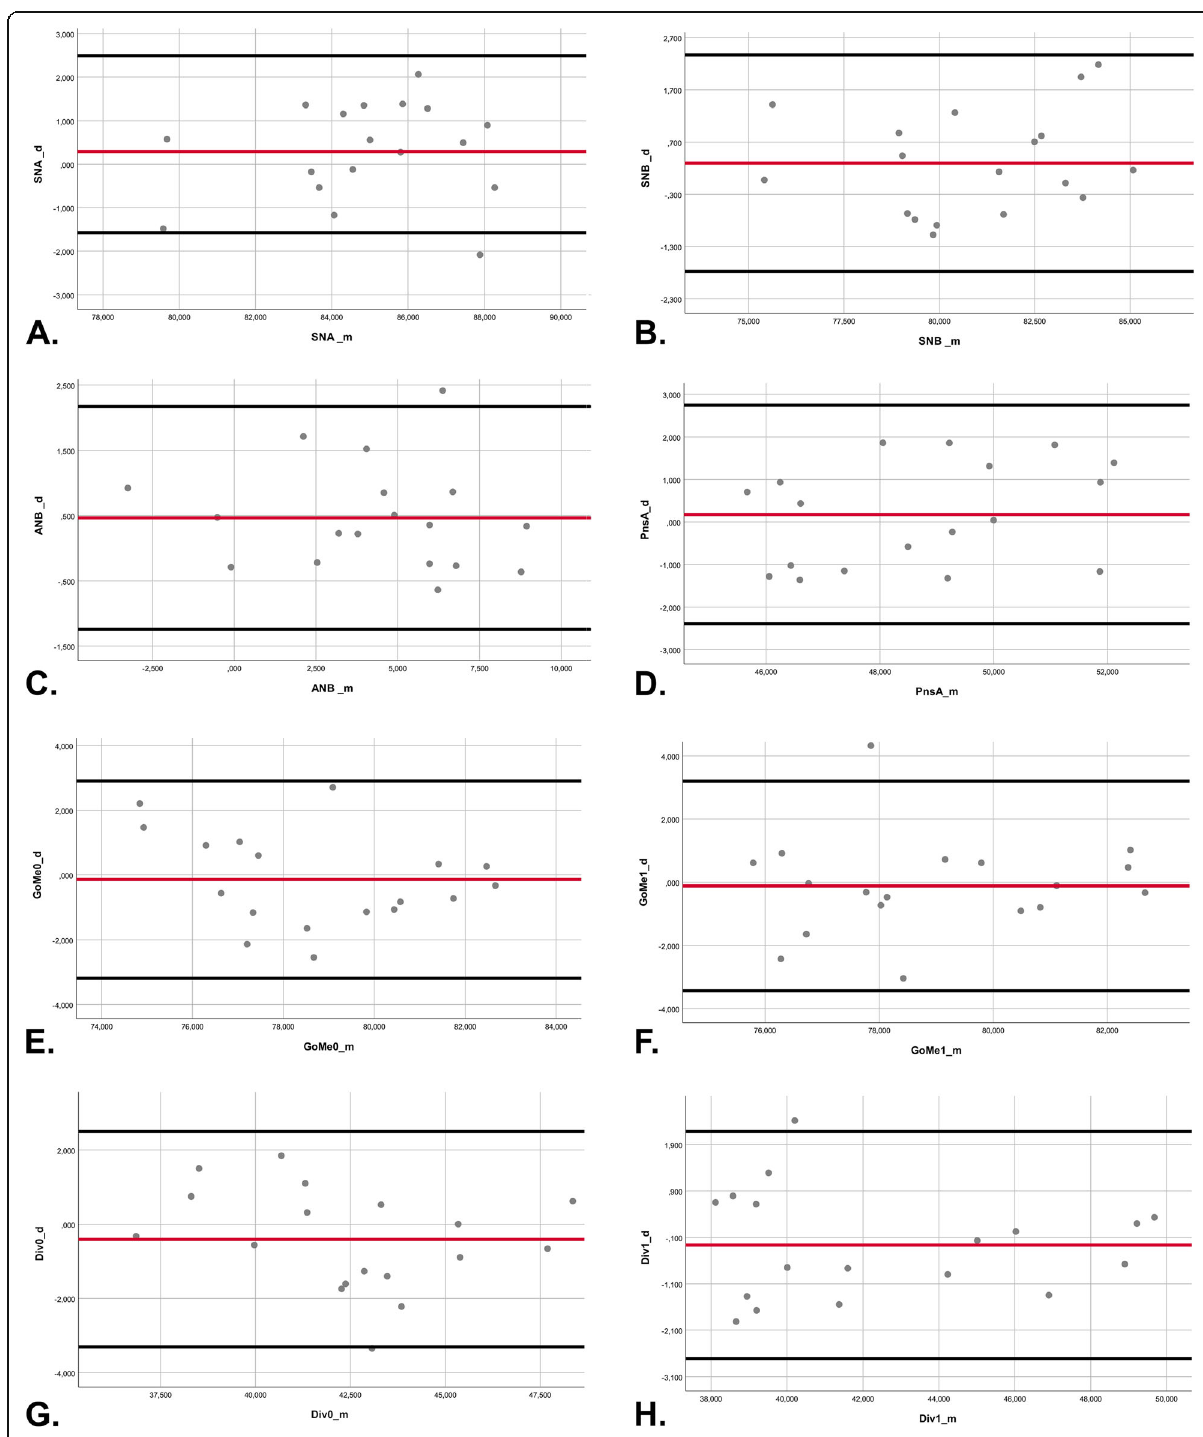
Fig. 3 Bland-Altman plots show the differences between the measurements on CBCT and 3T-MRI. Red lines represent the mean of all differences (bias), and black lines represent the 95% limits of agreement. Exemplary measurements: a SNA angle, b SNB angle, c ANB angle, d PNS-A distance, e Go R-Me distance, f Go R-Me distance, g intermaxillary divergence R angle, and h intermaxillary divergence L